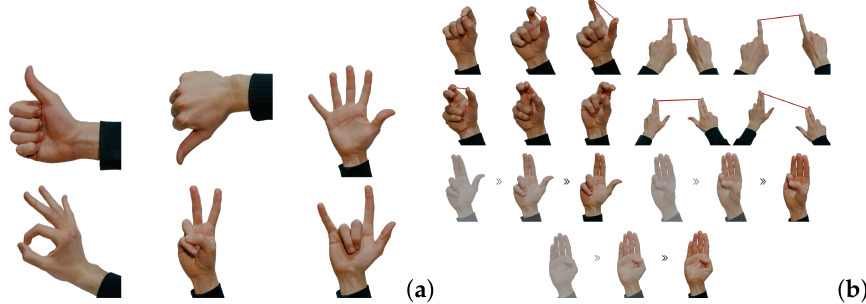
Figure 8. Proposed gesture set. ( a ) Static gestures: thumb up, thumb down, open hand, ok, peace, rock. ( b ) Dynamic gestures: simple pinch, combo pinch, simple rotation, combo rotation, two fingers swipe right/left, three fingers swipe right/left, four fingers swipe right/left. Adapted from [28]. Static gestures are fixed hand poses predicted directly by the FFNN. The FFNN inputs the coordinates provided by the MediaPipe framework, based on the current camera